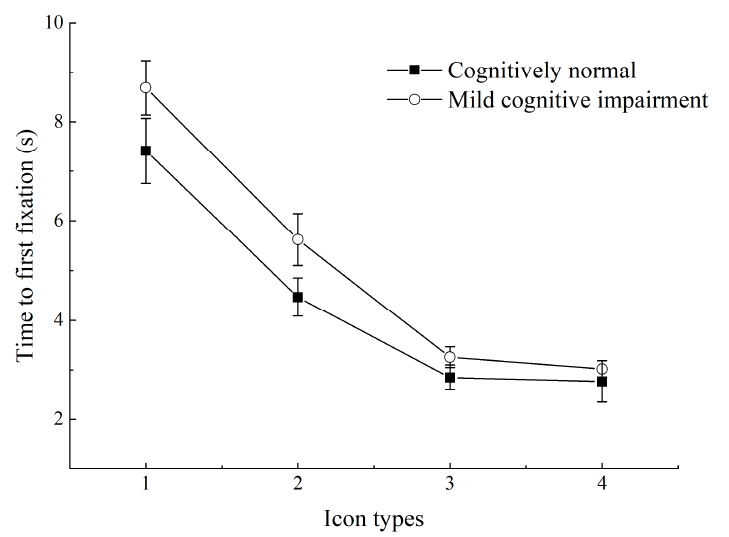
Figure 5. Time to first fixation for different icon types in older adults with different cognitive levels. (1) Flat icons (FIs); (2) skeuomorphic icons (SIs); (3) FIs plus text; (4) SIs plus text.